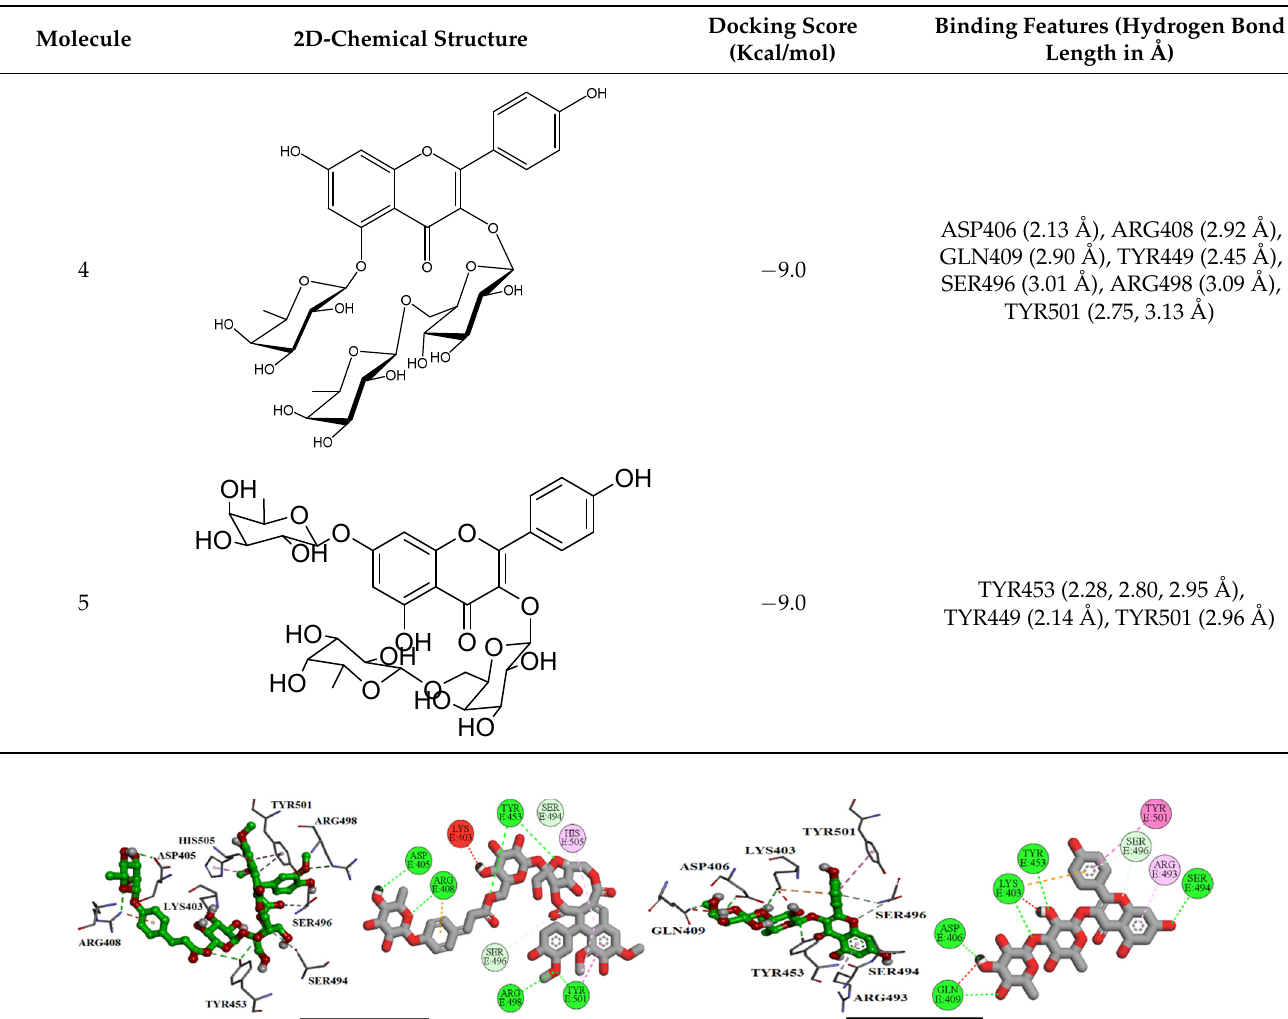
lar binding behaviors, with an influential hydrogen bond with SER496, ARG498, and TYR501, and additional hydrogen bonds with multiple residues inside the Omicron BA.1 binding pocket.